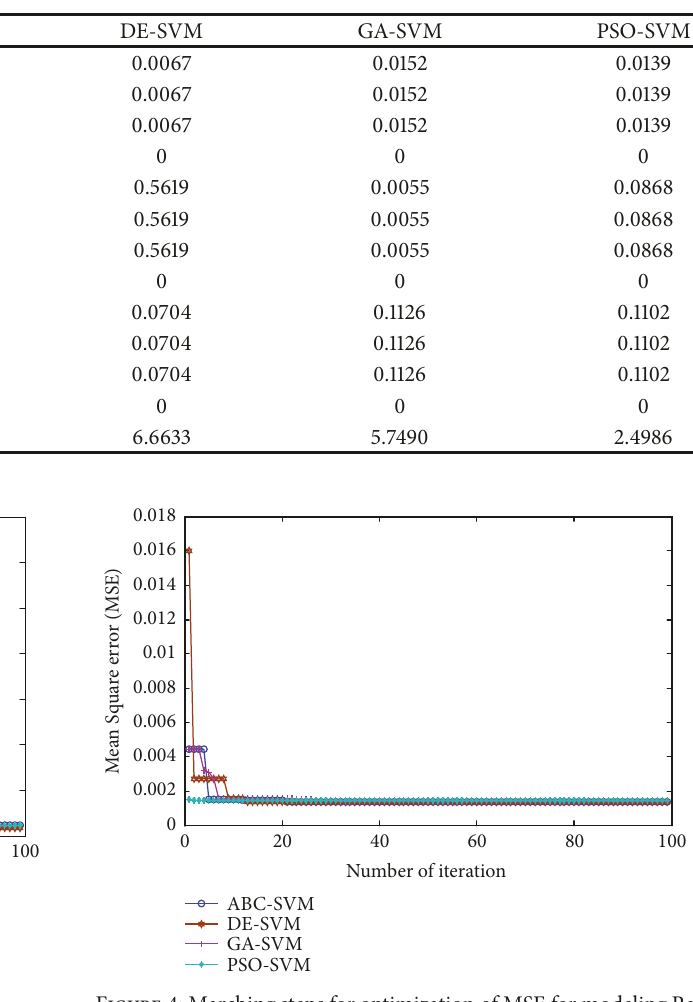
Table 6: Statistical results of 30 runs obtained by ABC-SVM, DE-SVM, GA-SVM, and PSO-SVM models for Compacted Graphite Iron.